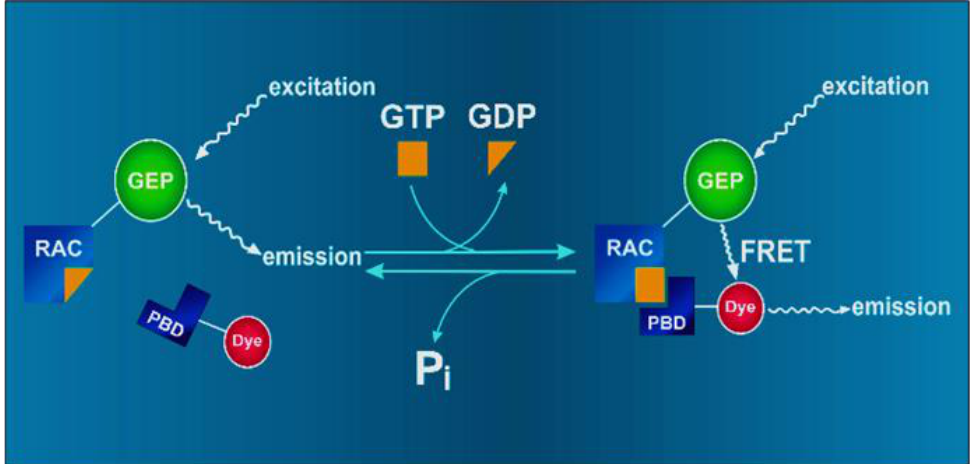
Figure 5. Local activity of Rac along with GTPase, which can balance protrusion and adhesions formed migratory cells by using two - chain probe - based FRET. formed migratory cells by using two-chain probe-based